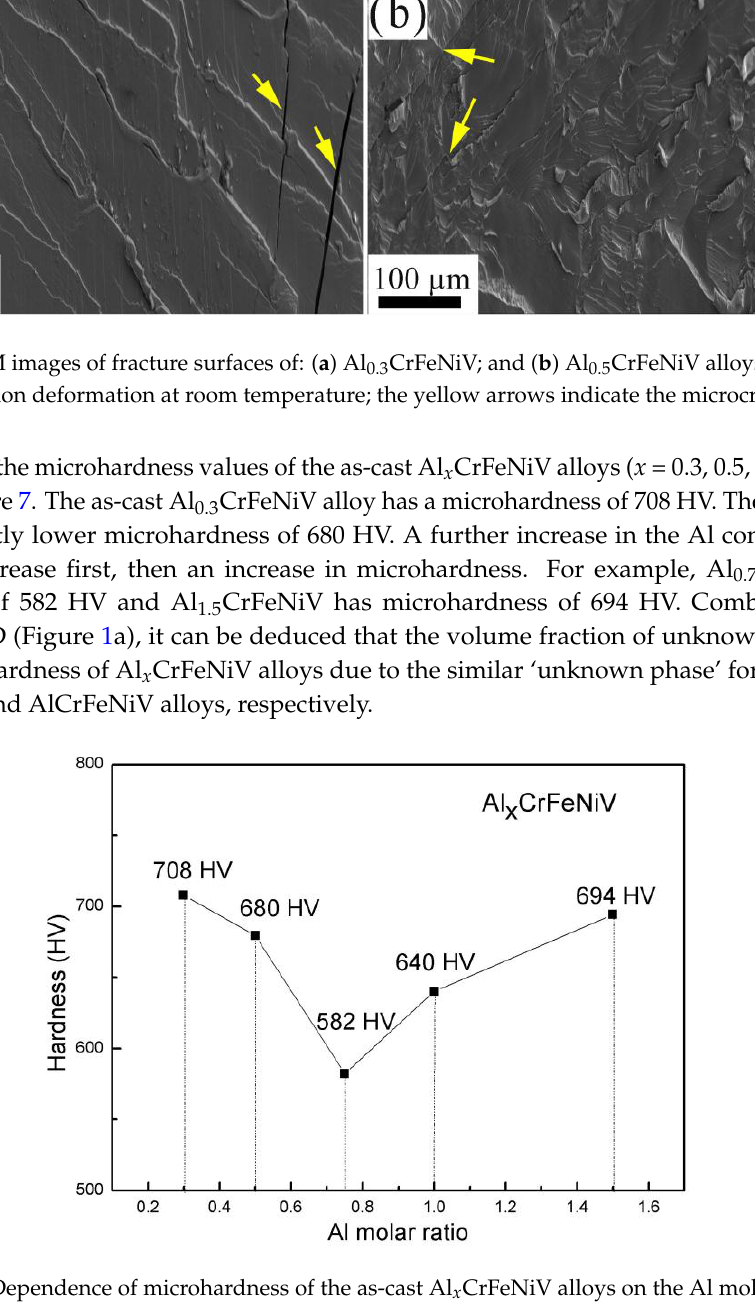
Figure 7. Dependence of microhardness of the as-cast Al x CrFeNiV alloys on the Al molar ratio.